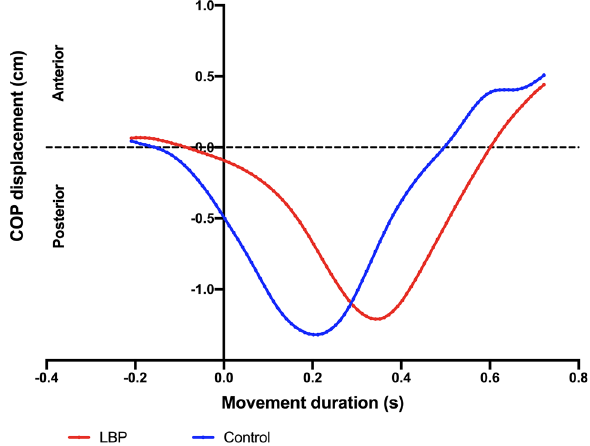
Figure 6. Anteroposterior COP displacement during arm movement of a typical participant recorded during one single trial. CLBP participants presented an earlier COP onset , a higher amplitude in COP APA , and less time to reach the maximum displacement after T 0 (lower COP timetopeak ). No differences was observed between groups in COP disp